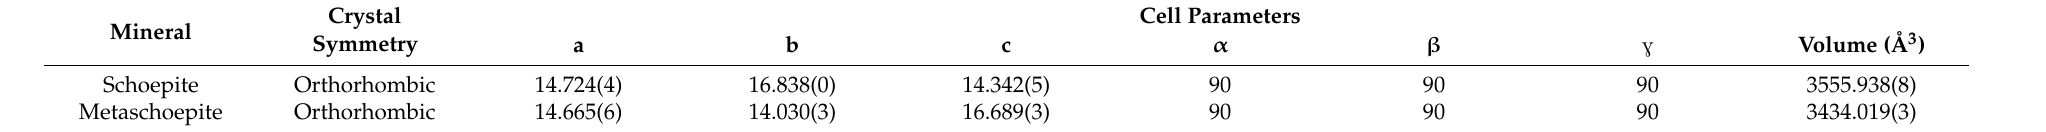
Table 9. Unit cell parameters of uranyl oxide-hydroxides from Podg ó rze